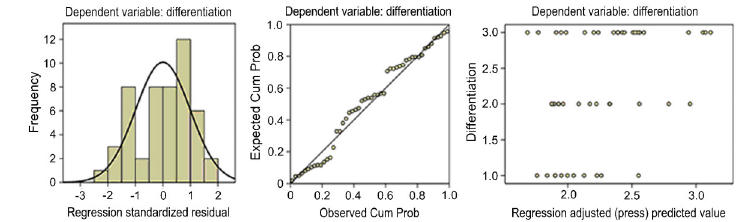
Figure 5. Multiple stepwise regression analysis in patients with lung